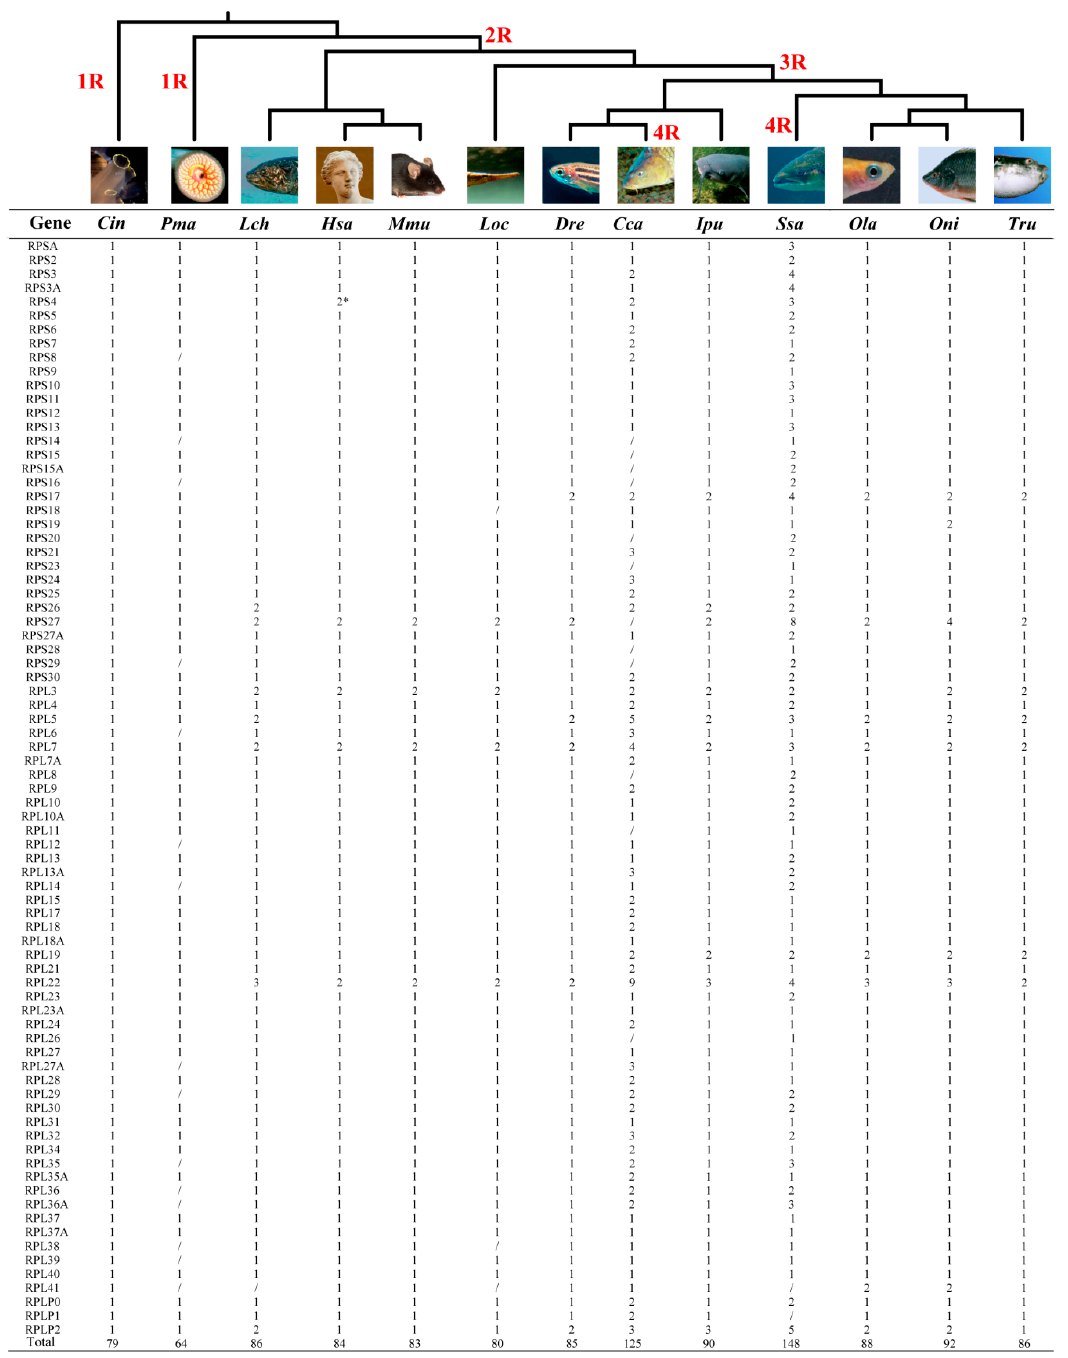
Figure 2. Phylogenetic relationship of 13 representative chordates analyzed and number variation of RP genes. 1R, 2R, 3R and 4R indicate the four rounds of WGD that occurred during vertebrate evolution. Slash indicates no homologous gene detected, probably due to secondary loss or incomplete genome sequences. * indicates two isoforms of RPS4 located on the human X and Y chromosomes. Cin , Ciona intestinalis ; Pma , Petromyzon marinus ; Lch , Latimeria chalumnae ; Hsa , Homo sapiens ; Mmu , Mus musculus ; Loc , Lepisosteus oculatus ; Dre , Danio rerio ; Cca , Cyprinus carpio ; Ipu , Ictalurus punctatus ; Ssa , Salmo salar ; Ola , Oryzias latipes ; Oni , Oreochromis niloticus ; Tru, Takifugu rubripes .